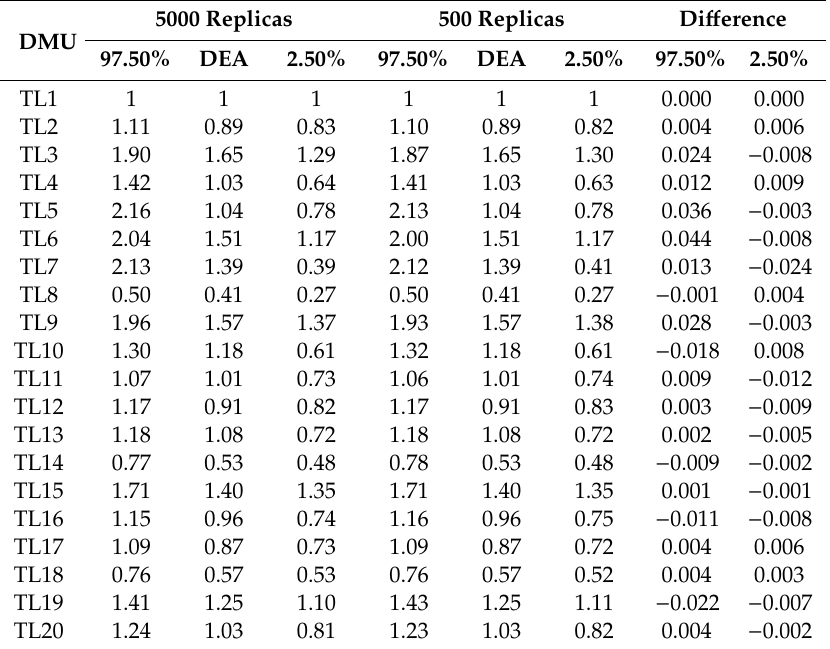
Table 5. 5000 vs. 500 replicas (Fisher 95%)